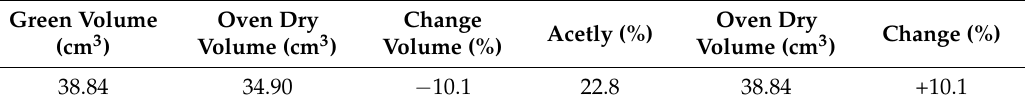
Table 3. Change in volume in wood from oven dry to acetylated